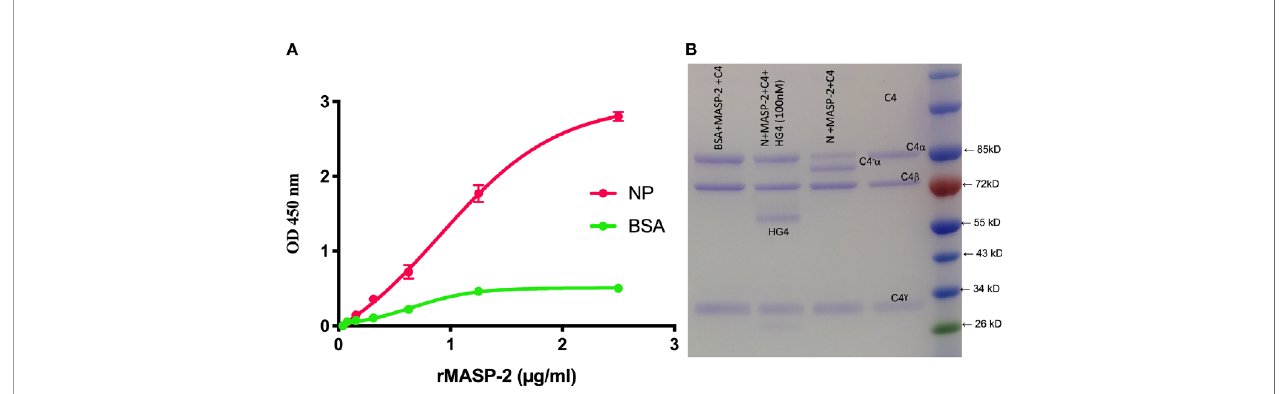
FIGURE 4 | MASP-2 binds directly to SARS-Cov-2 N-protein and mediates complement C4 activation. (A) Microtiter plates were coated with 2.5 m g/well N-protein or BSA as a control. Residual binding sites were blocked using 1% BSA. Serial dilutions of rMASP-2 were added, and binding was detected using an anti-MASP-2 mAb. MASP-2 bound to the NP protein in a concentration-dependent and saturable manner (A) . (B) In a parallel experiment, 1 m g of rMASP-2 in barbital buffered saline (BBS) was added to wells coated with NP or BSA. After 1 hr at 37°C, wells were washed and 1 m g of puri fi ed human C4 was added to each well. After 1 hr incubation at 37°C, the supernatant was collected and separated on SDS-PAGE. The results showed that rMASP-2 binds directly to NP and cleaves C4. Addition of HG4 (a mAb that inhibits MASP-2) inhibited MASP-2 mediated C4 cleavage. Puri fi ed C4 was run on the gel as a control.